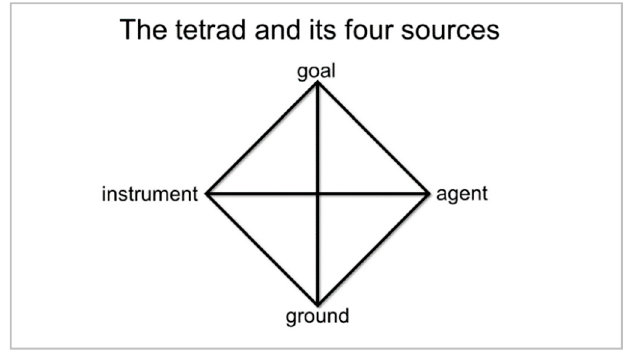
Figure 1. The tetrad and its four sources [9] (pp. 64-67).